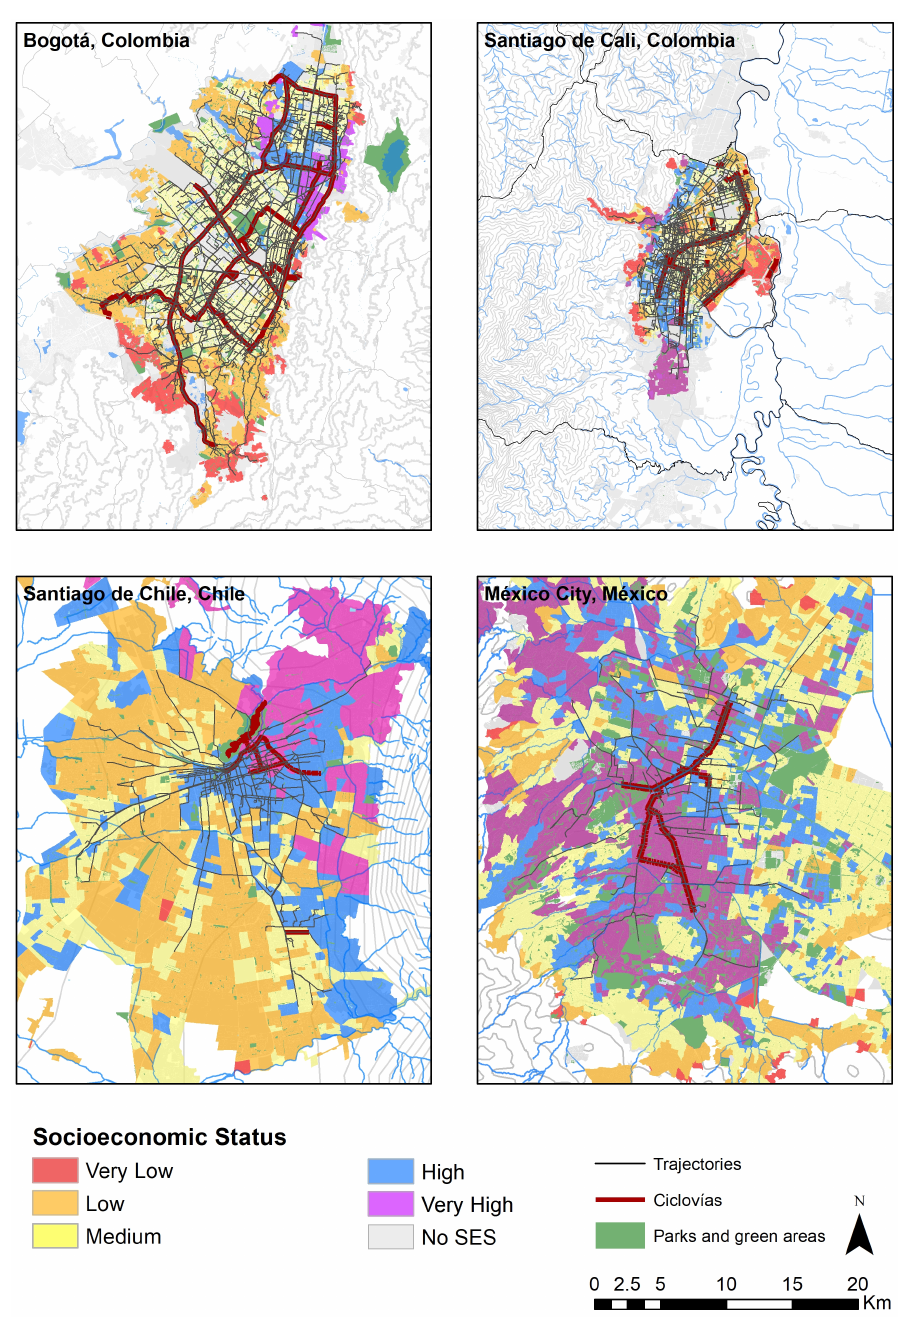
Figure 2. Participants trajectories through the Ciclov í a program. Geographical distributions of Socioeconomic Status, Ciclov í a Recreativa program routes, and green areas within each city are also